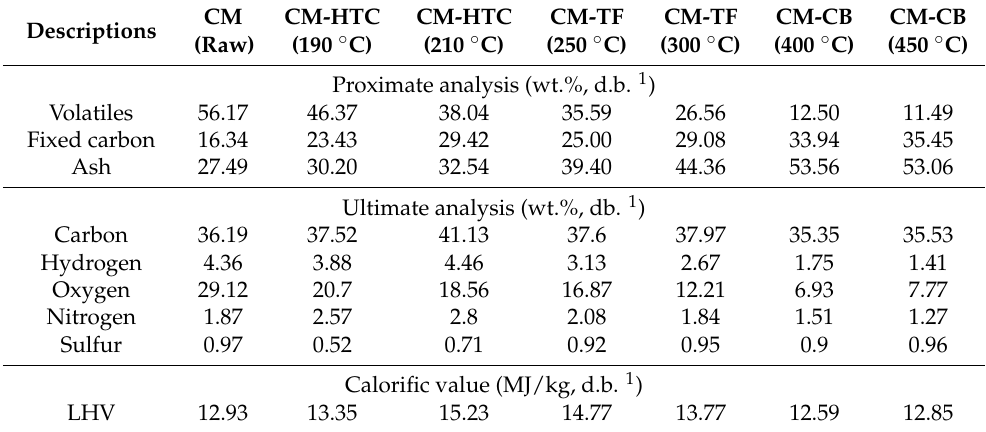
Table 2. Proximate, ultimate, and calorific analysis of the feedstock, hydrochar, torrefied char, and biochar